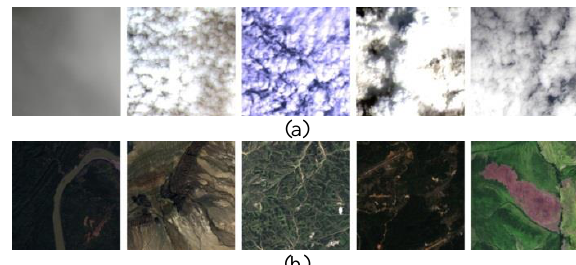
Figure 3. Training samples